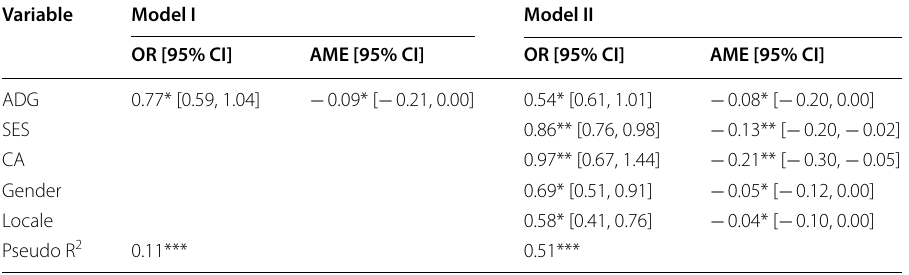
Model 2 (predicting intended track choice with a model including student’s ADG, SES, CA, gender and locale) [95% CI]: 95% confidence interval; OR: odds ratio; AME: average marginal effect; ADG: ability to delay gratification; SES: socio-economic status; CA: cognitive